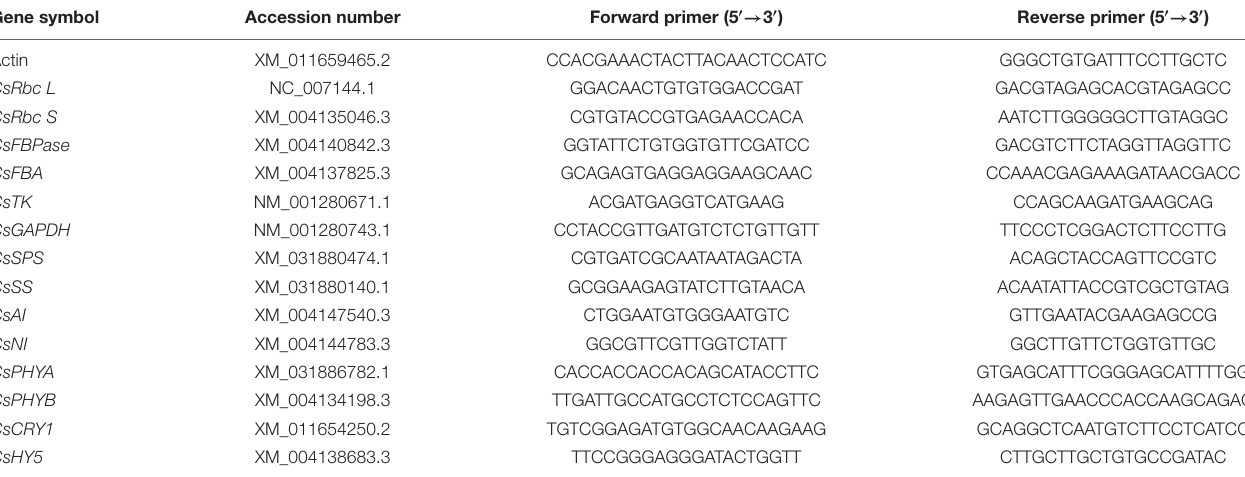
TABLE 1 | Primers used for quantitative real-time PCR assays. Gene symbol Accession